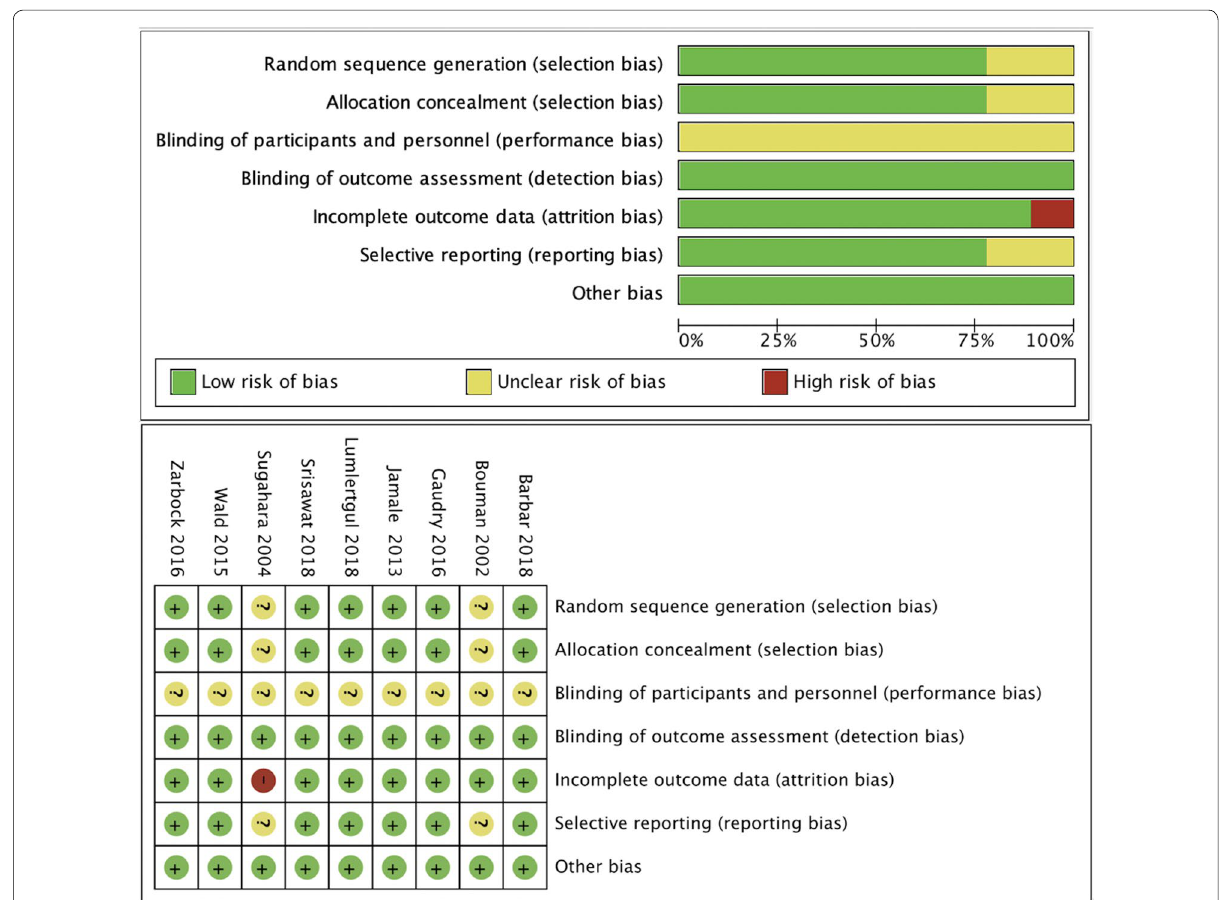
Fig. 2 Summary of risk of bias and applicability